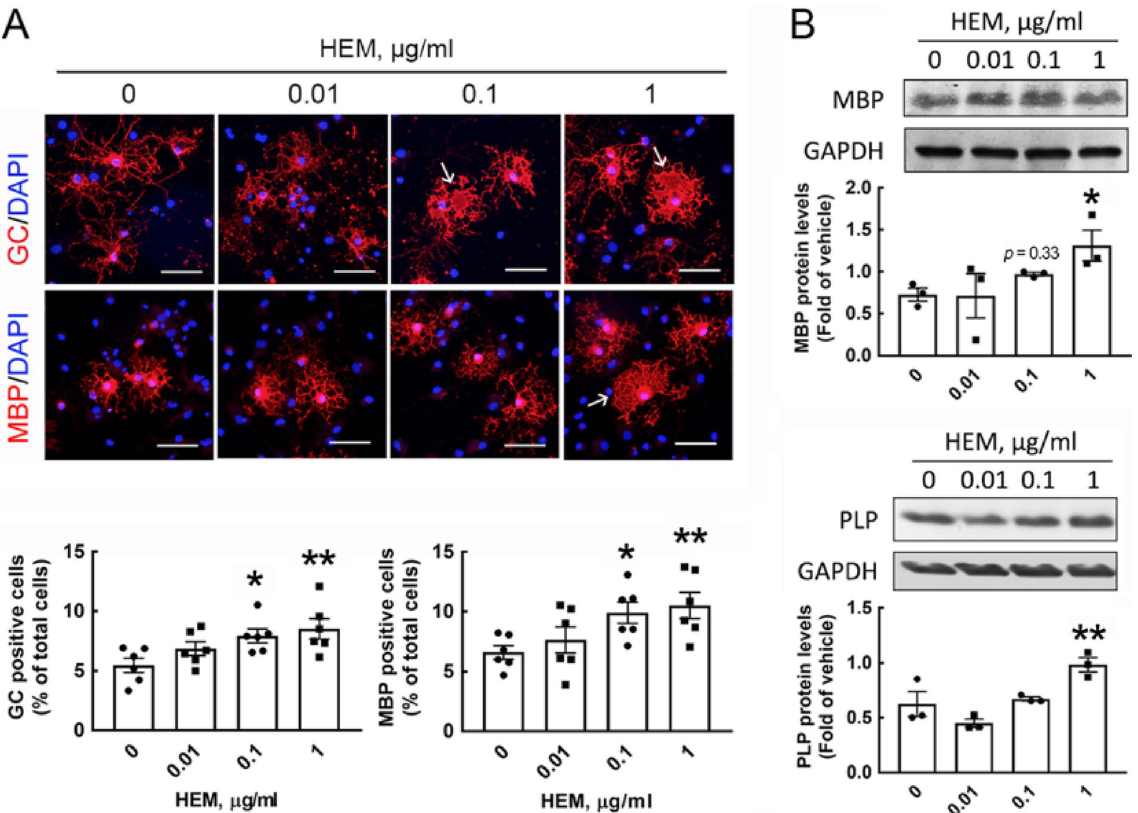
Figure 2. Crude HEM enhanced OL maturation. Crude HEM at the indicated concentrations was added to the cultures for 3 days after OPCs had been maintained in DM for 2 days (Fig. 1B). ( A ) The cultures were subjected to GC and MBP staining (red), followed by DAPI nuclear counterstaining (blue). GC + - and MBP + - OLs in the cultures were quantified as described in the “Materials and methods” section. Each spot represents as the data quantified from one photo captured from the cultures. Arrows shown in the representative images indicate OLs with the shape of an extended membrane. ( B ) Total proteins were isolated from cultures treated with crude HEM for 3 days and subjected to Western blot analysis to examine MBP and PLP protein levels. The intensity of the immunoreactive bands shown in the immunoblots was quantified by ImageJ software version 1.52a (https:// imagej. nih. gov/ ij/) and normalized to the level of GAPDH, which was used as a loading control. The immunoblot images used for quantification are provided in Fig. S5. Data are presented as the means ± SEMs of the three independent experiments. The raw immunoblot images are shown in Fig. S5. * p < 0.05, ** p < 0.01 compared with the control culture. Scale bar in ( A ) 50